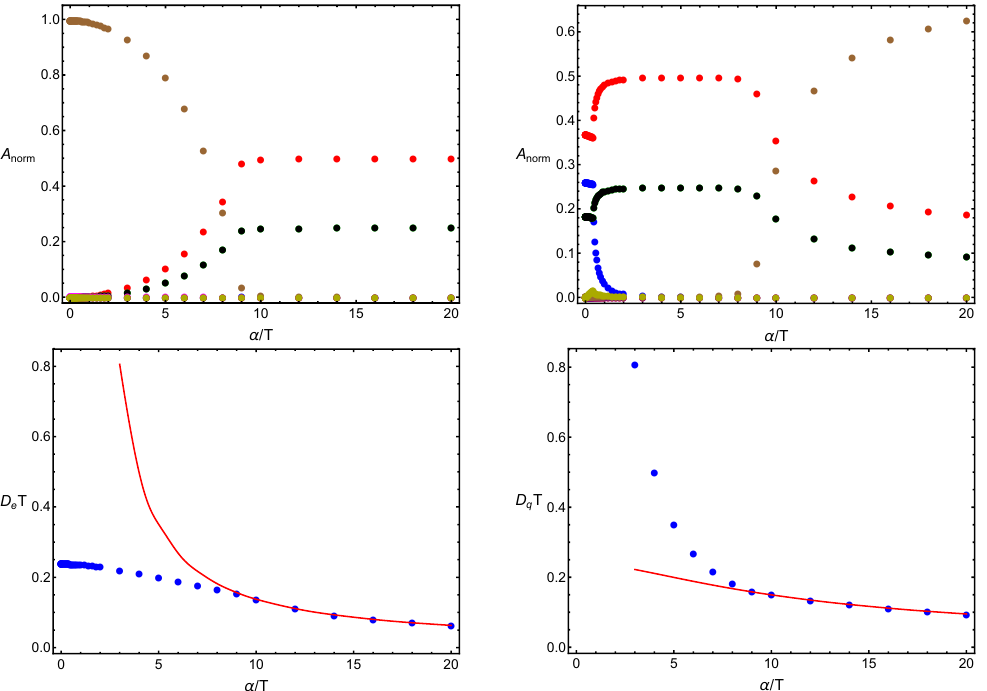
Figure 7 . Top : the amplitudes of the various operators for the two thermoelectric diffusion modes at T/µ = 5 . Bottom : the corresponding diffusion constants. The blue points are numerical data obtained from the amplitude data in the upper panel using the Fick’s law (B.3) as explained in appendix B. The red lines are the analytical formulas (4.9) valid in the incoherent limit, which is reached around α/T ∼ 10 . At that point, the support of the two modes decouple into energy density and charge density fluctuations. See also the figures in appendix